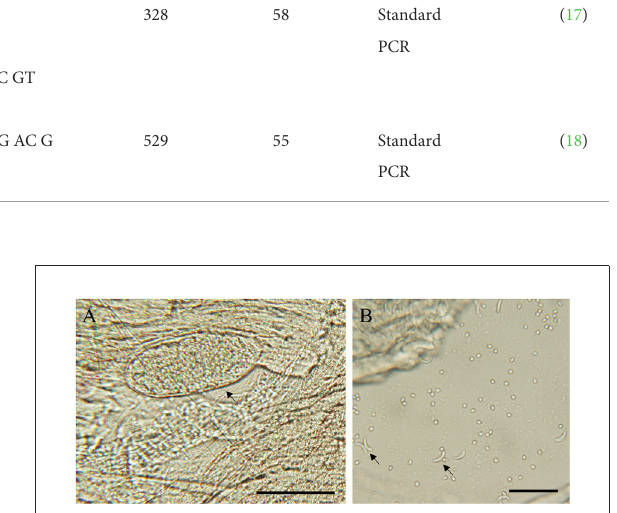
FIGURE1 Morphological characteristics of S. tenella in the myocardium of sheep. (A) light micrograph of a sarcocyst (arrow), unstained; (B) light micrograph of bradyzoites (arrow) in pepsin-digestion liquid; unstained. Bar = 50 µ m.